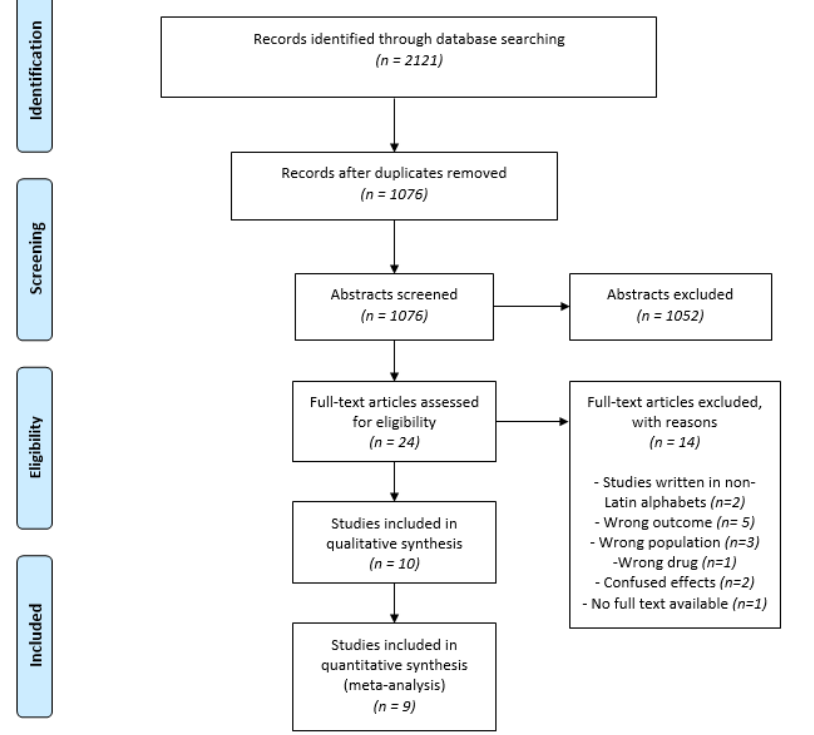
Figure 1. Flow diagram of inclusion process according to the PRISMA statement. Table 1. Summary of descriptive characteristics of included articles ( n = 10).